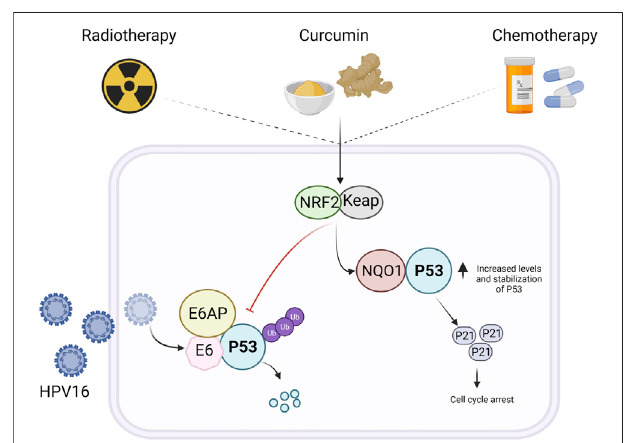
FIGURE 5 | p53 Stabilization by curcumin and synergy with routine therapy for the treatment of cervical cancer. Curcumin activates the Kelch-like ECH-associated protein 1-nuclear factor (erythroid-derived 2)-like 2 (Keap1/ Nrf2) pathway, leading to an increase in the levels of NAD(P)H:quinone oxidoreductase 1 (NQO1). NQO1 binds to p53, promoting the loss of the interaction between p53 and E6AP, a negative regulator, promoting p53 stabilization in cancer cells with wild-type p53, such as cervical cancer cells. Moreover, a promising area of study is that of evaluating the synergistic effect of curcumin with routine chemotherapy, thus procuring a better response to treatment and fewer adverse